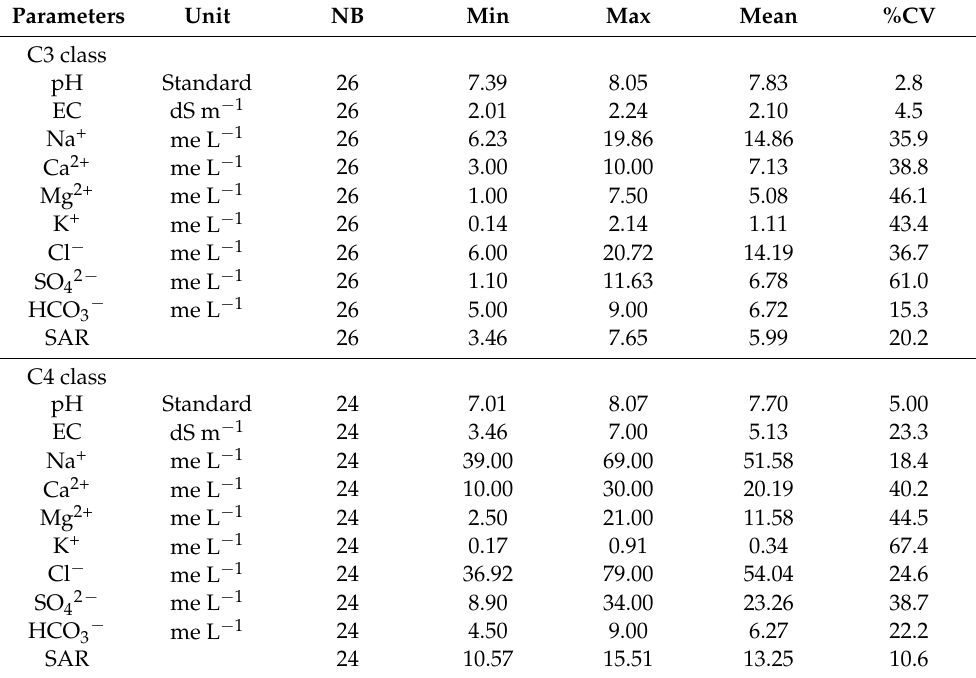
Table 1. Physicochemical characterization of water samples. C3 and C4 represent irrigation water classes based on water